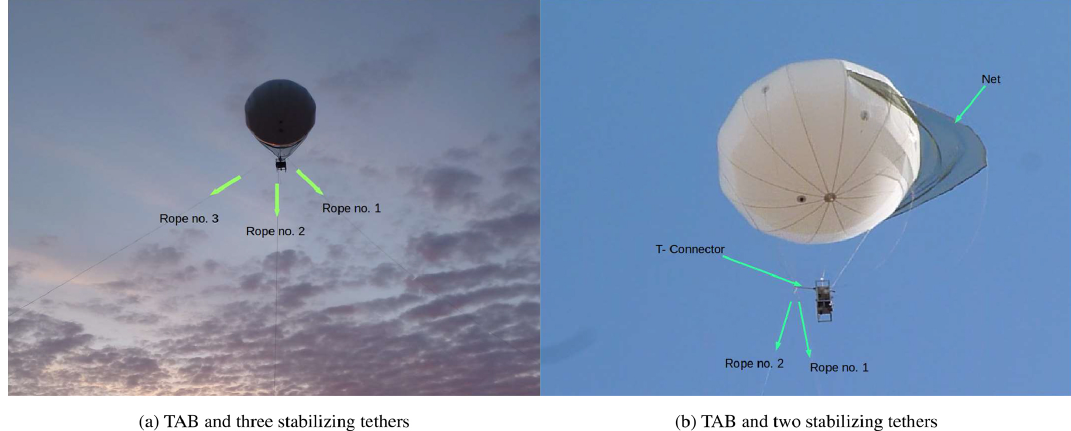
Figure 2. TAB at different atmospheric stability conditions tethered with two or three stabilization ropes in the mining